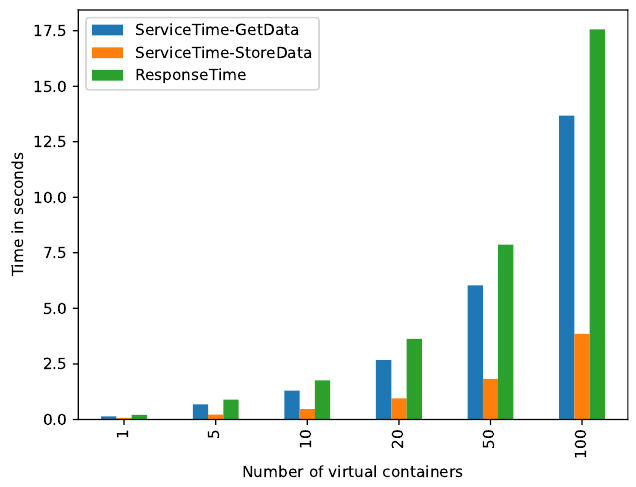
Figure 5. Service and response times produced by the tasks GetData and StoreData